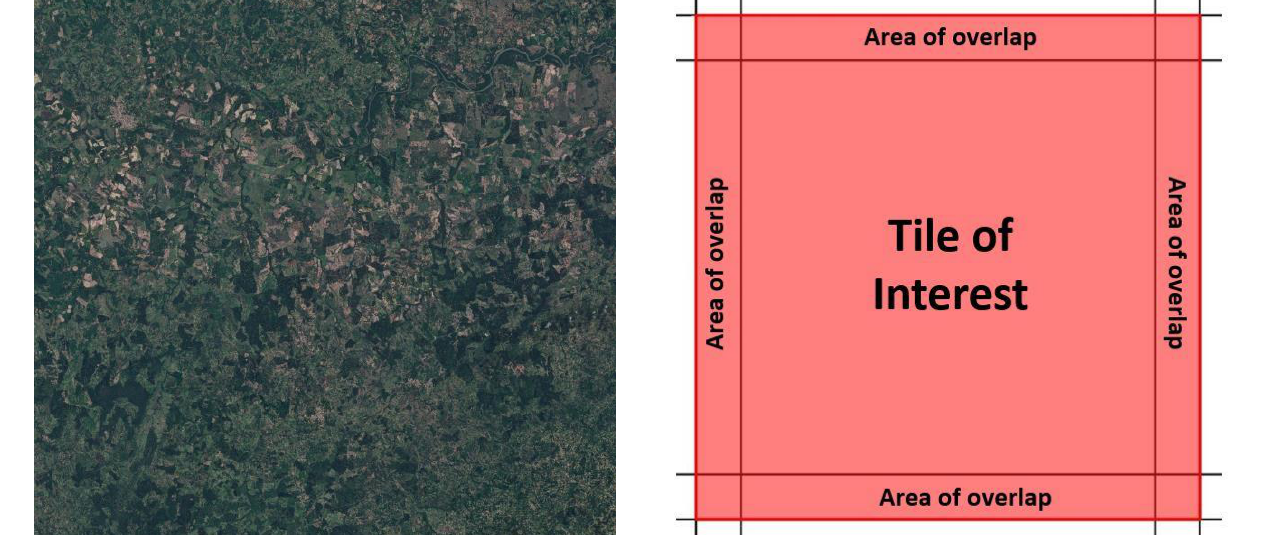
2.3 Generating a cloud-free mosaic .